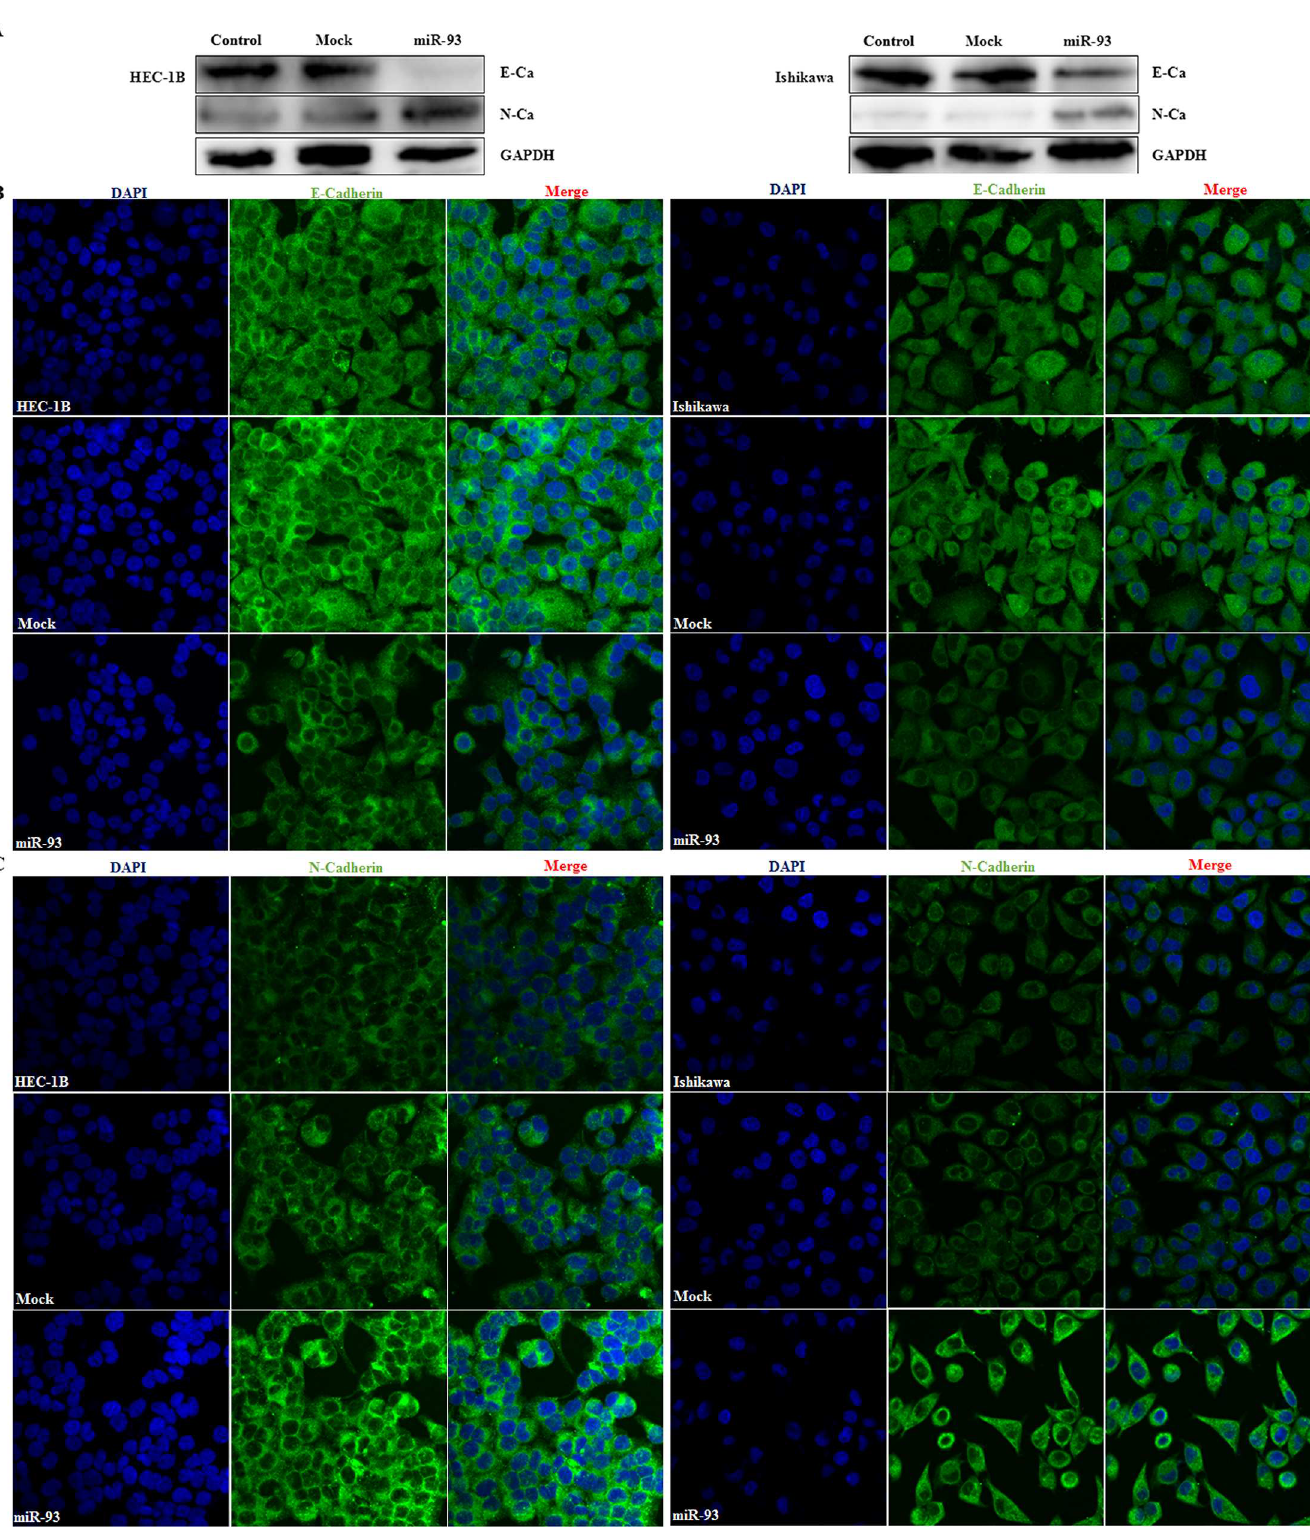
Fig 3. MiR-93 transfection downregulated expression of E-cadherin and upregulated expression of the N-cadherin. After miR-93 transfection, E- cadherinwas downregulated and N-cadherin was upregulatedin Western blot assay (A). Besides, Immunofluorescence assay was used to determine subcellularlocalization of E-cadherinand N- cadherin(B & C).